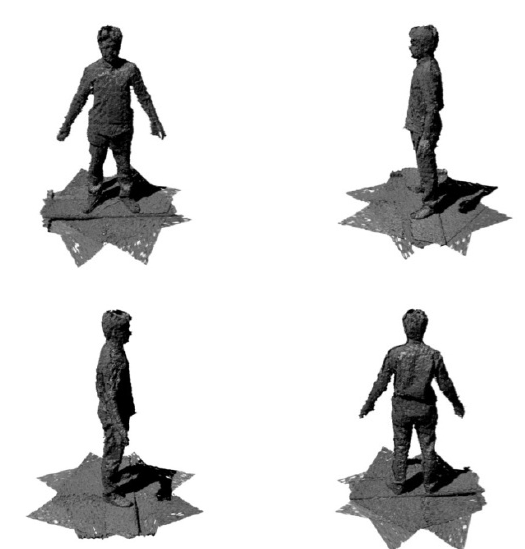
Figure 9. A full body model integrated from 8 sensor readings of unfiltered point